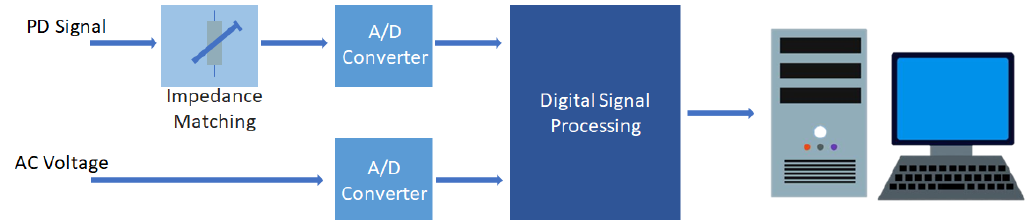
Figure 3. Basic diagram of a digital measurement system [26].